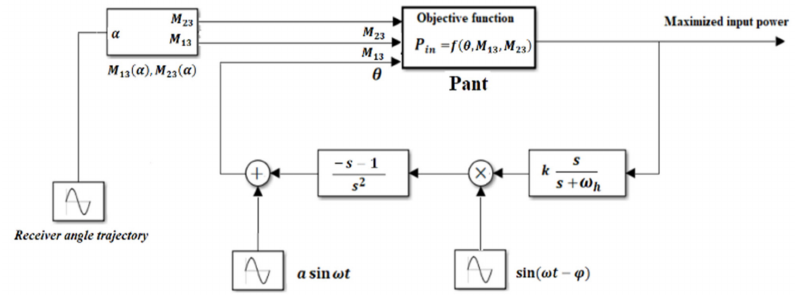
Figure 11. Extremum seeking scheme for 2D omnidirectional WPT power maximization.